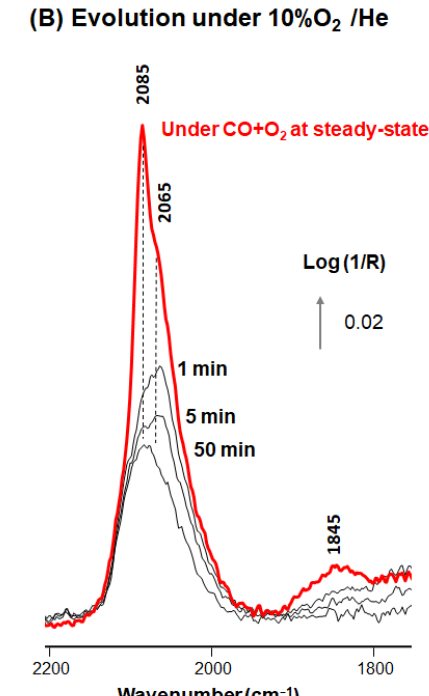
Figure 5. Relative area of the linear carbonyl DRIFTS band as a function time following the removal of CO from the feed measured over Pt supported on ( A ) alumina, ( B ) titania and ( C ) ceria. The sample was previously left 15 min under 10% O 2 /He, and then 15 min under 0.5 % CO + 10% O 2 /He. Feed: 100 mL min − 1 of ( (cid:78) ) He and ( ) 10% O 2 (cid:35)